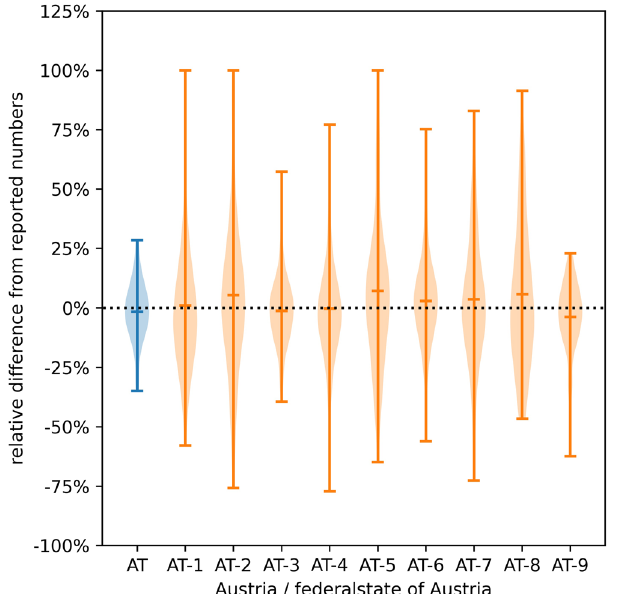
Fig. 3 Evaluation of the forecasting performance for federal states. The distribution of relative differences over all 72 forecasts to the reported data for Austria (AT) and all nine federal states (AT-1 to AT-9) is shown. Since the mean relative differences are close to zero, no persistent systematic over or underestimation of the cases occurs. For large federal states such as Lower Austria (AT-3) and Vienna (AT-9), forecasts are more reliable. The underlying data is found in Supplementary Data 3.